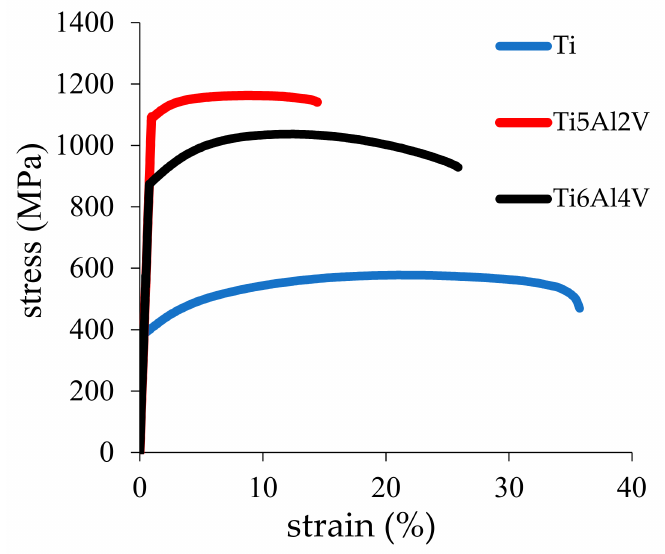
Figure 5. Stress-strain curves for the Ti alloy specimens obtained by SPS.